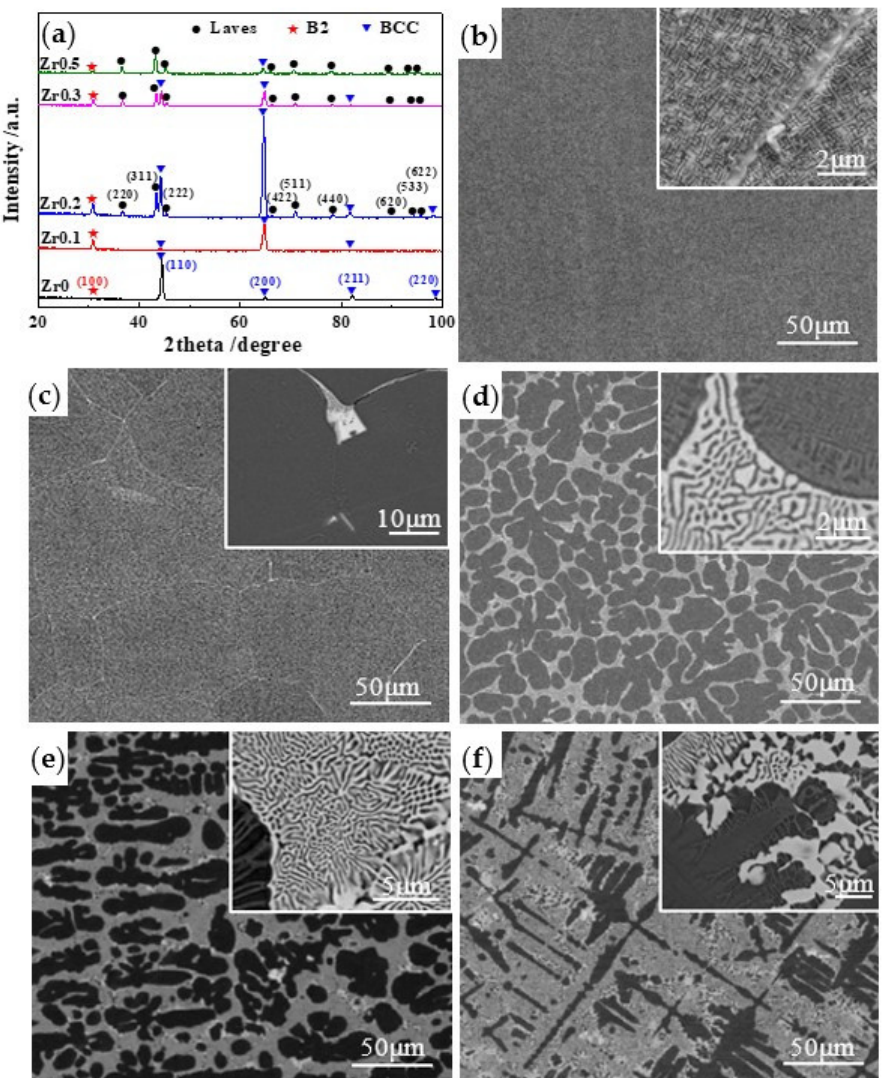
Figure 3. XRD patterns and SEM micrographs of as-cast AlCoCrFeNiZr x ( x = 0, 0.1, 0.2, 0.3, and 0.5) alloys: ( a ) XRD patterns, ( b ) x = 0, ( c ) x = 0.1, ( d ) x = 0.2, ( e ) x = 0.3, and ( f ) x = 0.5.